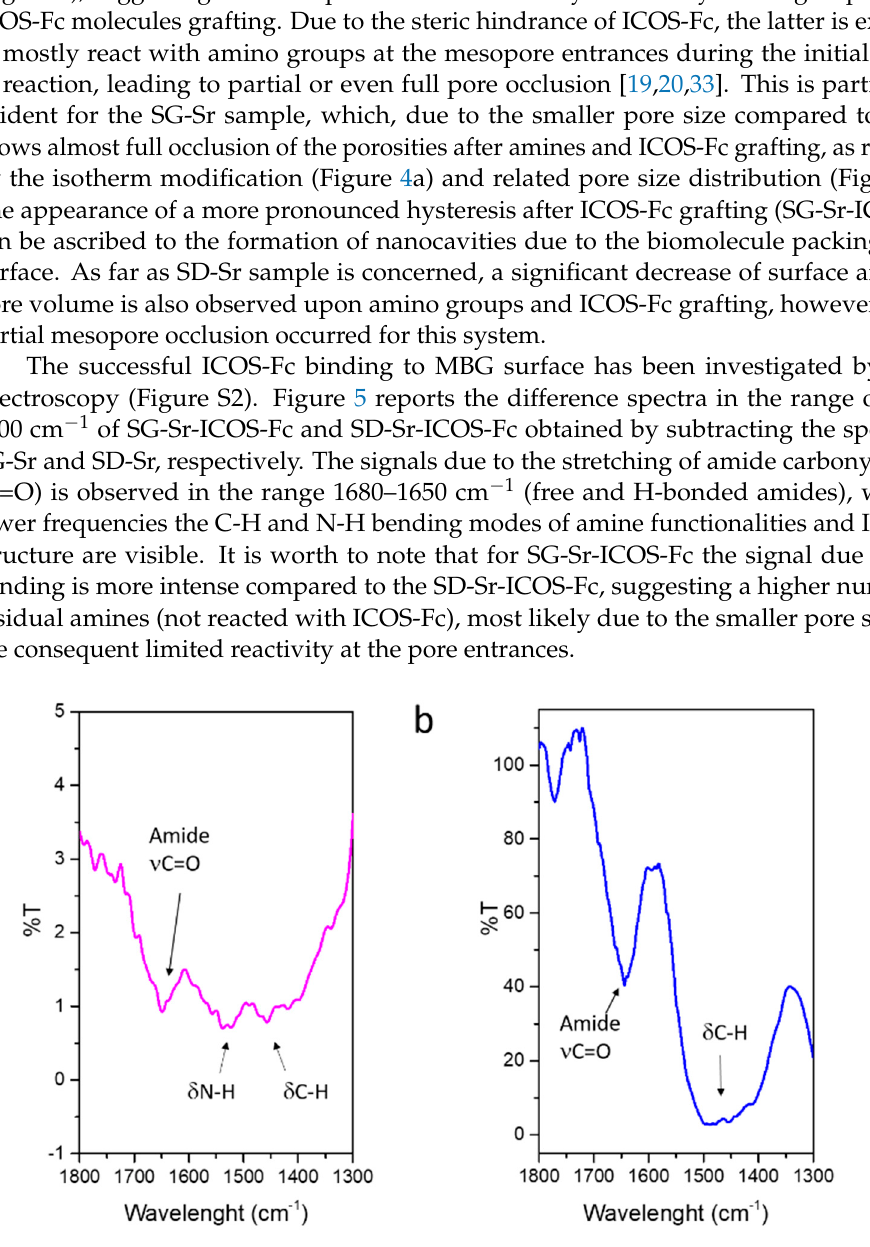
Figure 5. Difference FT-IR spectra of SG-Sr-ICOS-Fc ( a ) SD-Sr-ICOS-Fc ( b ); the spectra of SG-Sr SD-Sr have been subtracted, and SD-Sr have been subtracted, respectively.